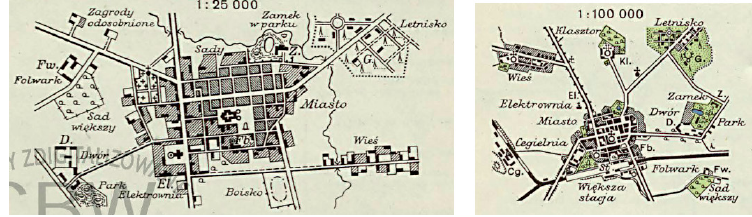
Fig. 5. Built-up areas on the maps of the Polish Military Geographical Institute